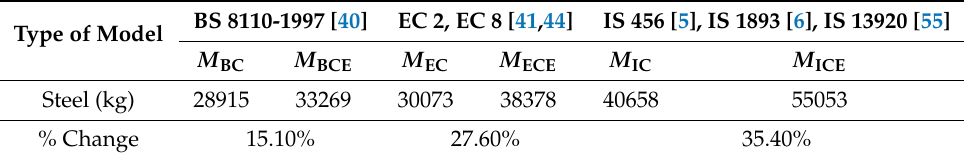
Table 7. Comparison of design